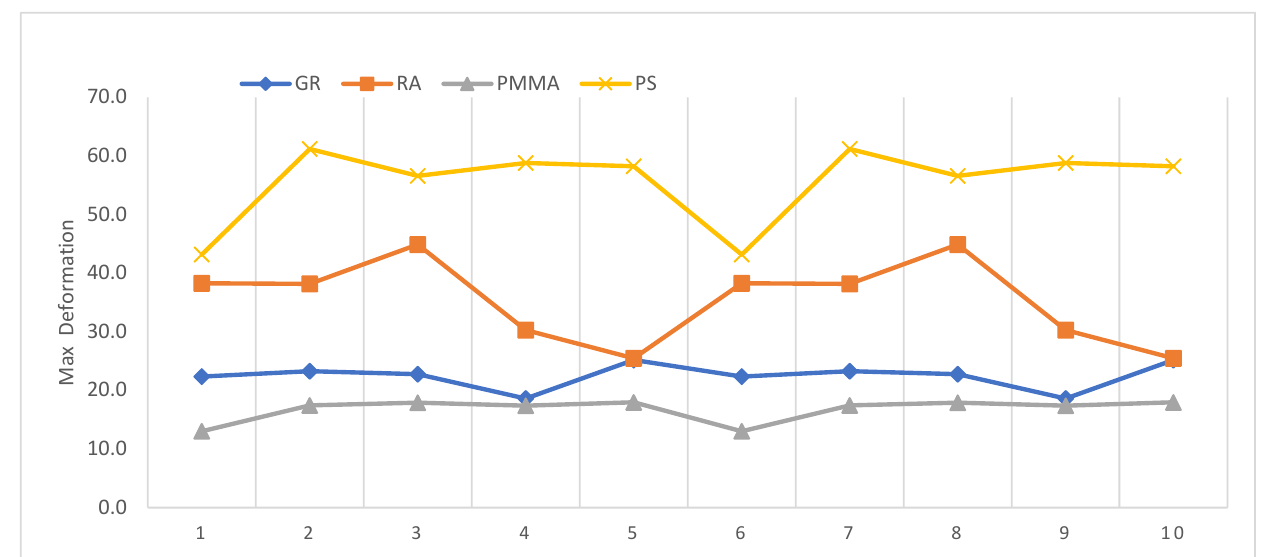
Figure 3. Comparison of the deformation of GR, RA, PMMA and PS materials.